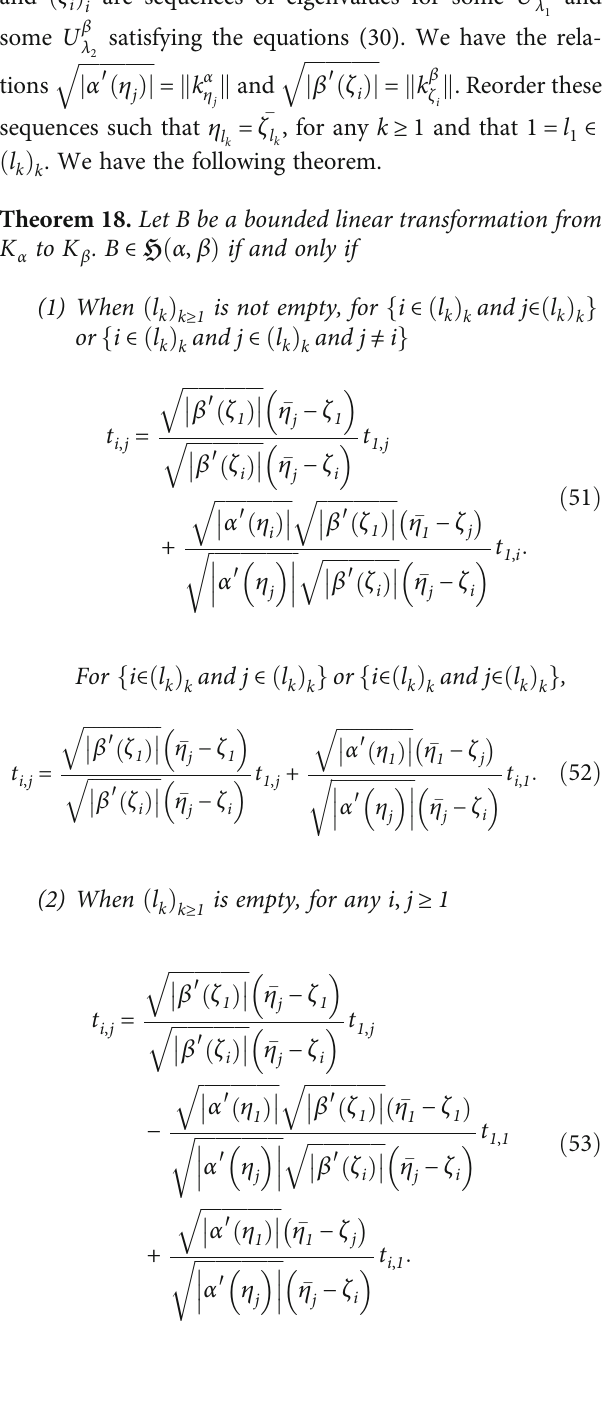
ffiffiffiffiffiffiffiffiffiffiffiffiffiffiffiffi (cid:12) β ′ ζ ð Þ (cid:12) 1 ffiffiffiffiffiffiffiffiffiffiffiffiffiffiffi (cid:12) β ′ ζ ð Þ (cid:12) i